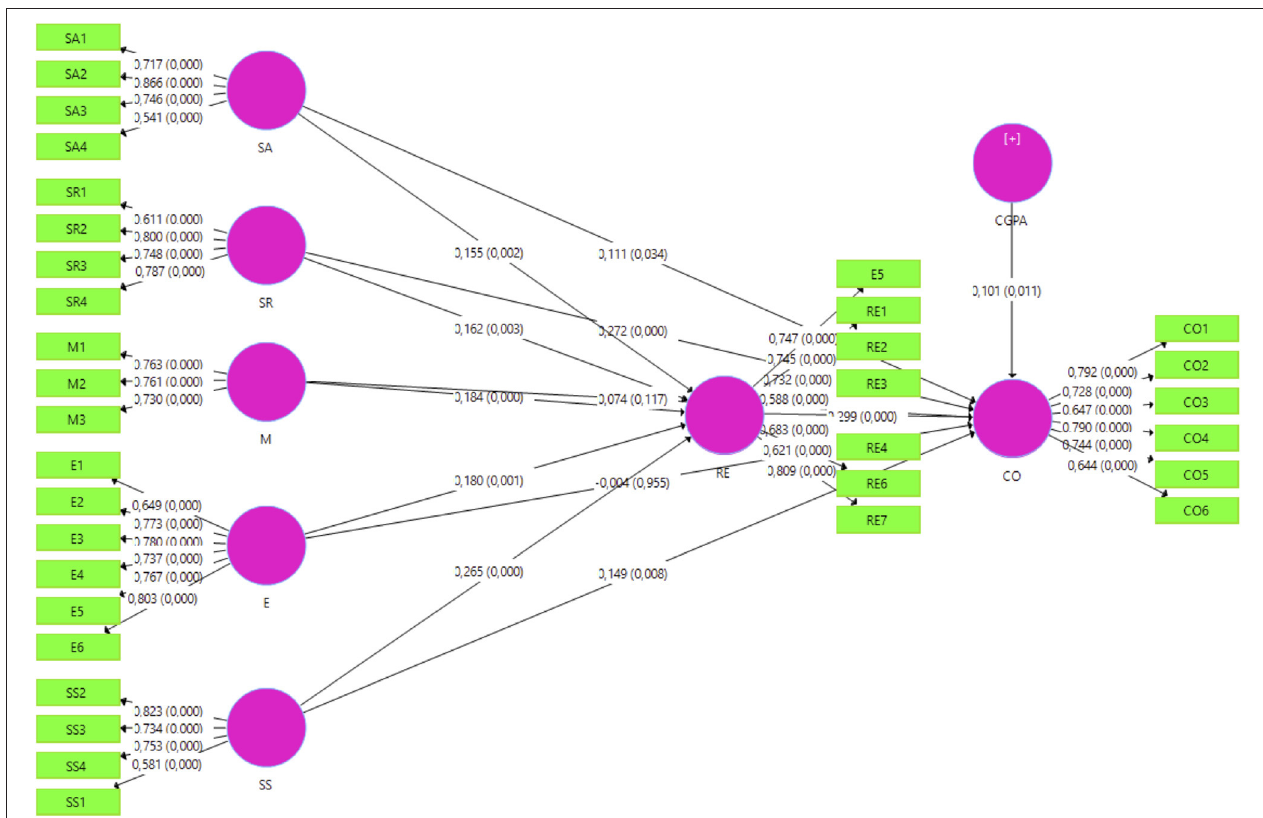
FIGURE 2 | Determines the theoretical constructs with R 2